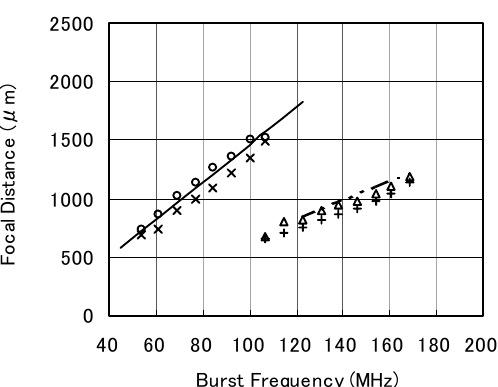
Fig.7-3 Focal Distance